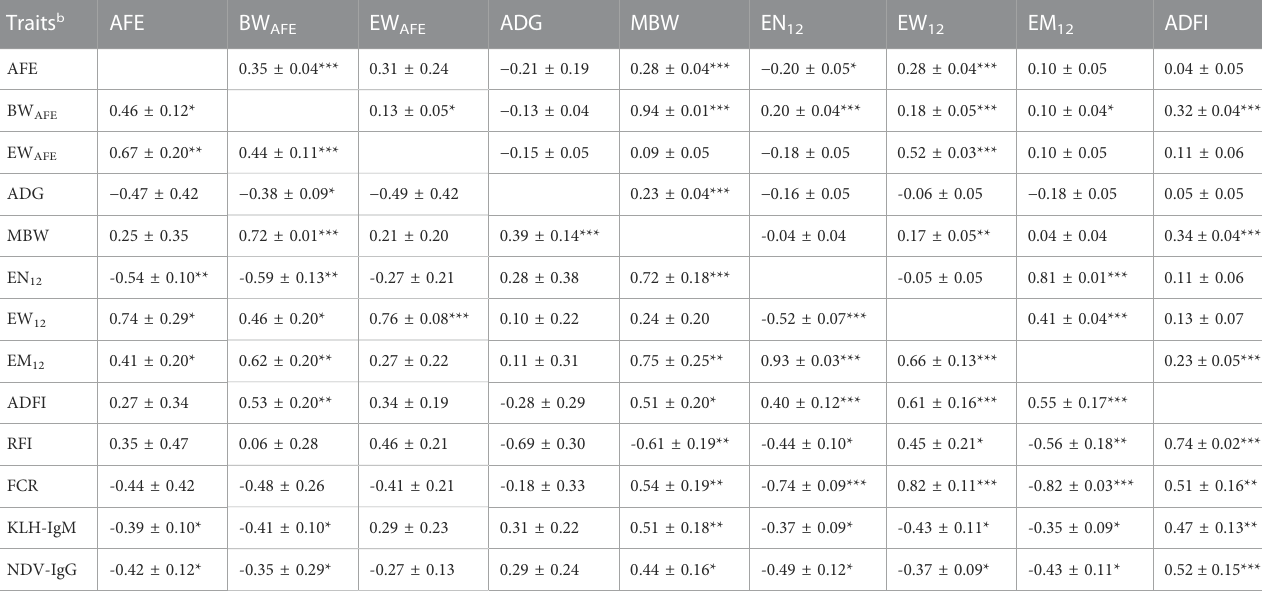
TABLE 4 Estimates of genetic a (lower diagonal) and phenotypic a (upper diagonal) correlations among production, feed ef fi ciency and immune traits during the laying period (12 weeks from on-set of lay). Traits b